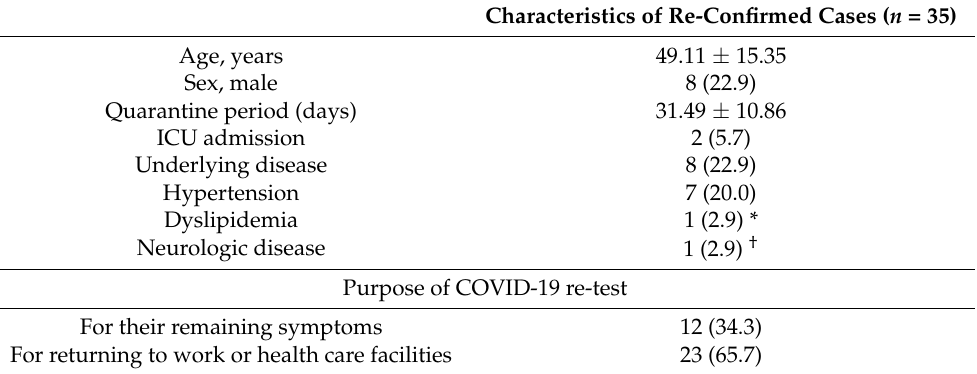
Table 4. Clinical characteristics of the patients with re-confirmed COVID-19 after viral clearance evidenced by a negative test